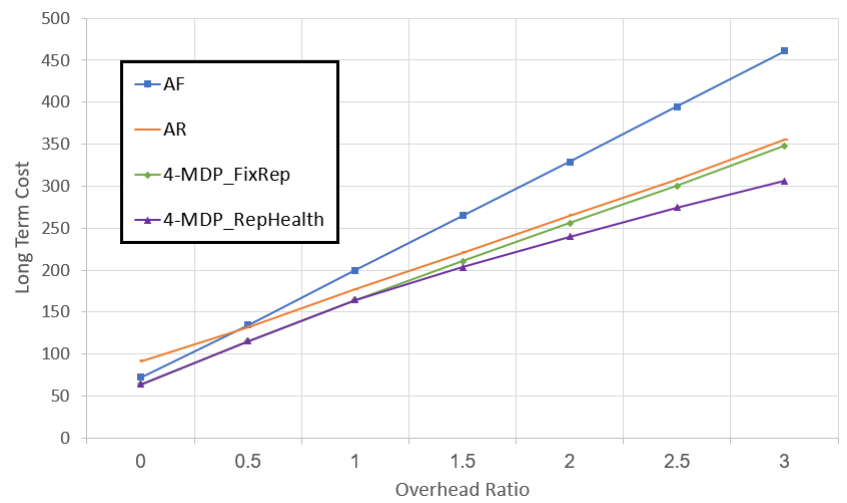
Figure 9. Long-term costs as a function of the overhead ratio. Evaluating the N-MDP RepHeal algo-